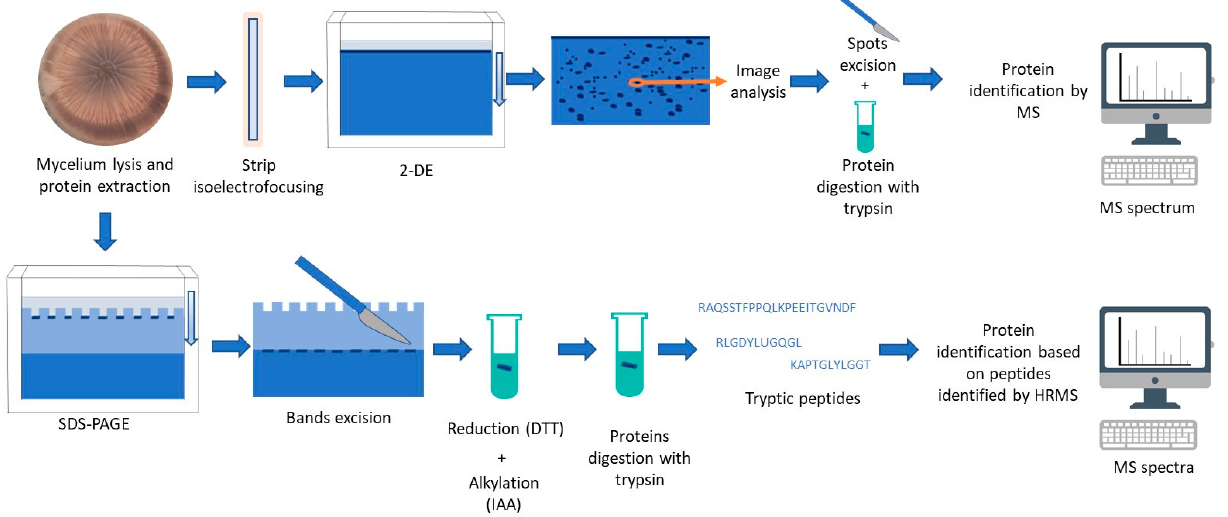
Figure 1. Workflow of proteomics analyses by two-dimensional gel electrophoresis (2-DE), upper line, and sodium dodecyl-sulphate polyacrylamide gel electrophoresis (SDS-PAGE) previous to high resolution mass spectrometry (HRMS) analyses, lower line. DTT: dithiothreitol; IAA: iodoacetoamide-mediated; MS: mass spectrometry.